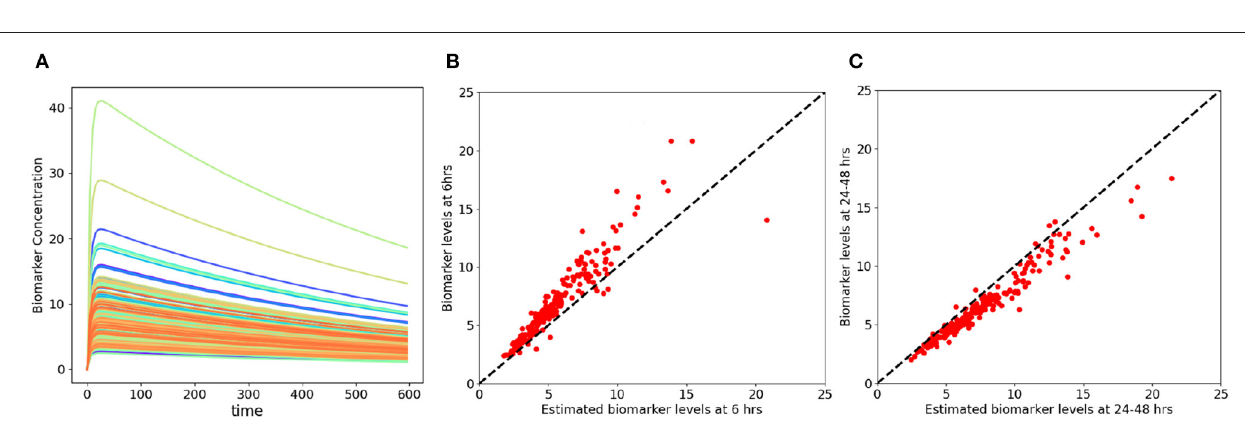
FIGURE 12 | NF-L kinetic modeling utilizing modified kinetic parameters of T max = 24 h and k a = 0.2 hr − 1 . (A) Time concentration curves estimated by the revised kinetic parameters for NF-L biomarker. (B,C) Model estimated biomarker level vs. measured biomarker level at 6 and 24–48 h for revised kinetic parameters of NF-L. (B) x-axis corresponds to model estimated C p at 6 h and Y-axis corresponds to measured C p at 6 h. (C) x-axis corresponds to model estimated C p at 24–48 h and y-axis corresponds to measured C p at 24–48